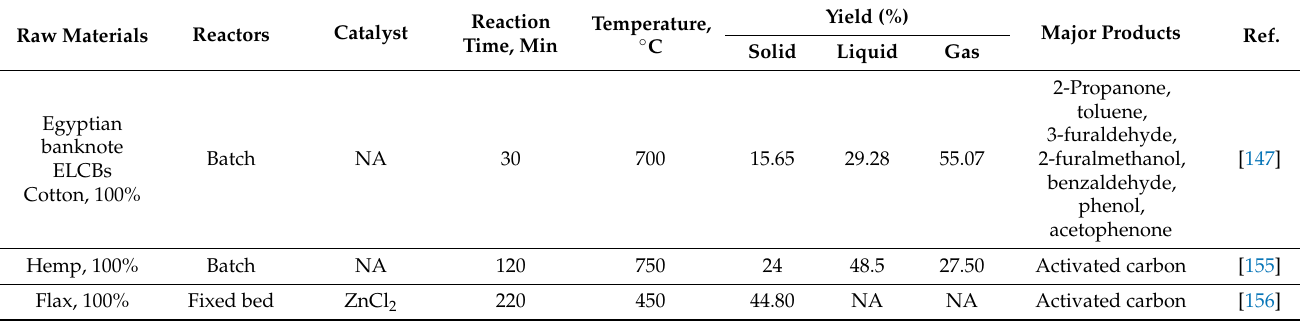
Table 4. Yields of solid, liquid, and gas products produced via textile waste